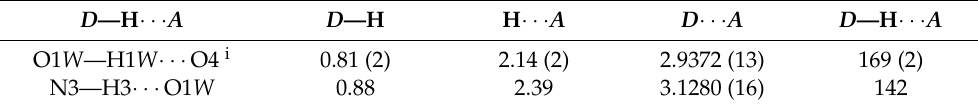
Table 7. Hydrogen-bond geometry (Å, ◦ ) in 4b